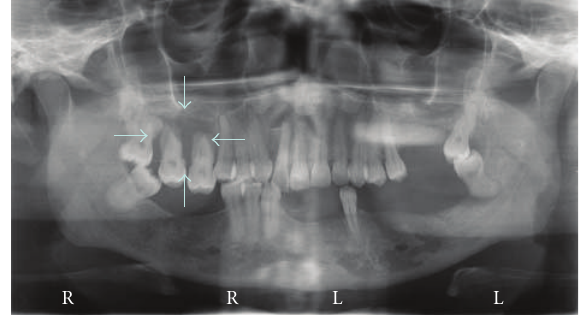
Figure 6: Case 4. Panoramic radiograph showing lytic area with floating teeth.